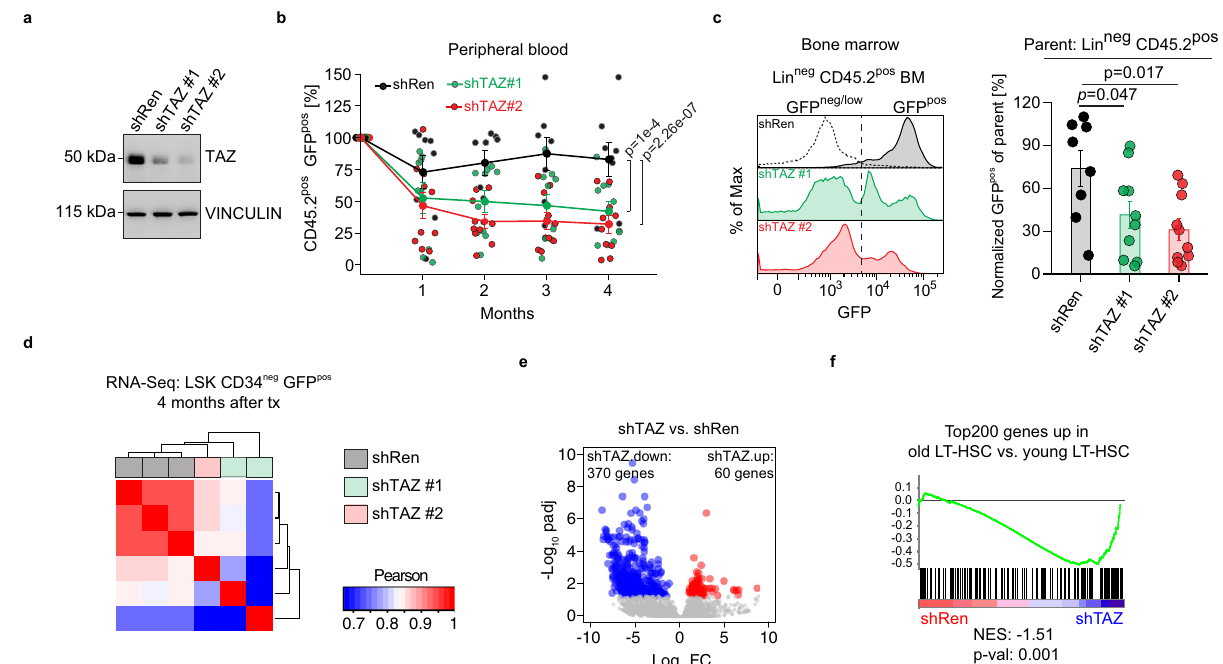
Fig. 4 | CLCA3A1 high HSCs depend on high TAZ expression. a Immunoblot of NIH3T3 cells infected with the indicated shRNAs. An shRNA targeting Renilla (shRen)servesascontrol.Theexperimentwasindependentlyrepeatedthreetimes. b PB analysis after transplantation of CLCA3A1 high HSCs transduced with the indi- cated shRNAs. The GFP pos population in the donor CD45.2 pos compartment was analyzed for 4 months post-transplantation (shRen: n =8, shTAZ#1: n =10, shTAZ#2: n =10, three independent transplantations, two-way ANOVA with Tukey HSD post hoc test). c Representative GFP fl ow cytometry plots of Lin neg CD45.2 pos BMcells4monthsaftertransplantation(left).Thedottedlineindicatesthenegative control for GFP (gated on CD45.1/2 pos supporting cells).Right panel:percentage of